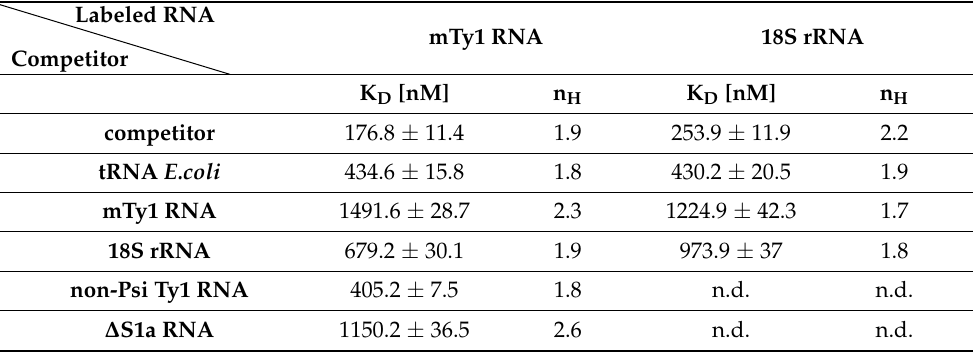
Table 2. Impact of RNA competition on Ty1 Gag-p49 binding to mTy1 RNA and 18S rRNA. Binding parameters for Ty1 Gag-RNA interactions were obtained based on the Hill equation. Mean ± SD of K D from at least three independent MST experiments. n.d.: not